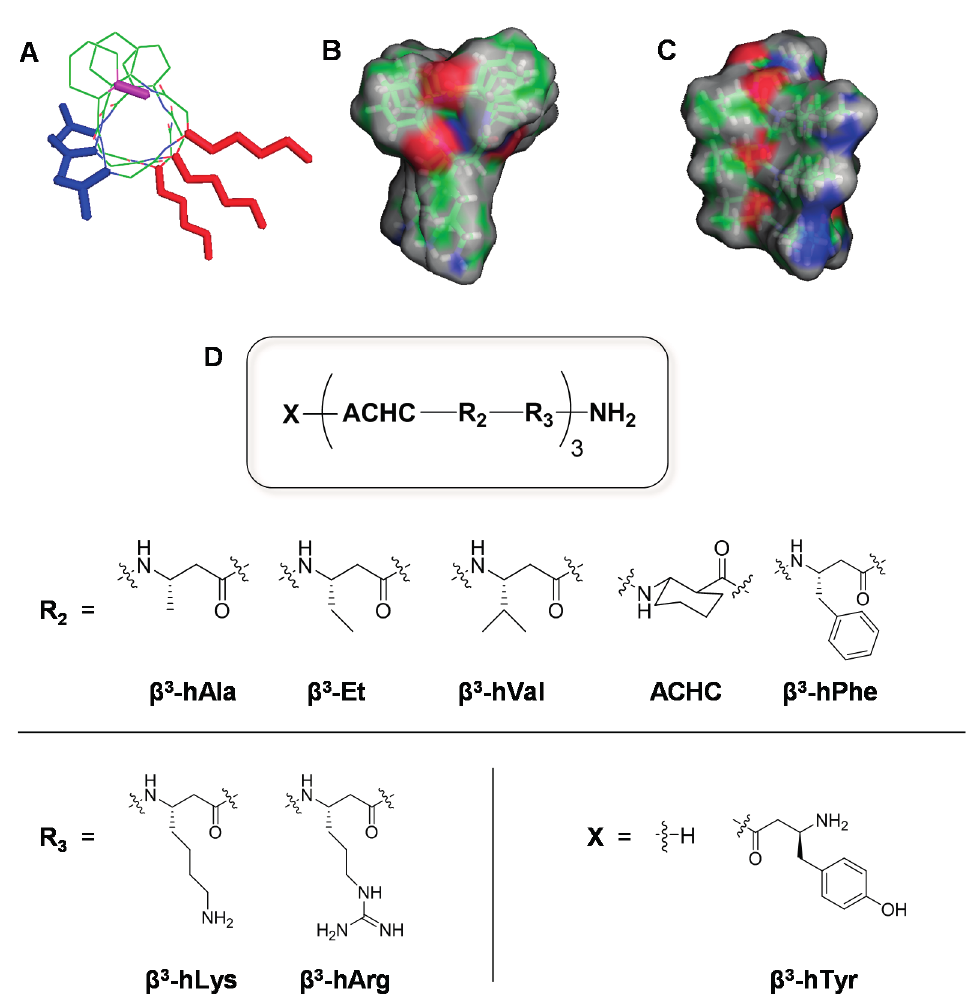
Figure 1. 14-Helical β -peptide design and chemical structures. 3D structures ( A , B and C ) were generated based on available crystal structure data and then geometry was optimized using Gaussian 03 at the B3LYP/6-31G level. ( A ) Stick view of β -peptide 4 . The N-terminus (pink), hydrophobic side chain (blue), and cationic side chain (red) are indicated in color. ( B , C ) Surface views of β -peptide 4 . Surface colors represent atom type H (gray), O (red), and N (blue). ( D ) Chemical structures of β -peptides containing a helix-stabilizing ACHC residue and the N-terminus (X), hydrophobic (R 2 ), and cationic residues (R 3 ) were altered as indicated to vary peptide